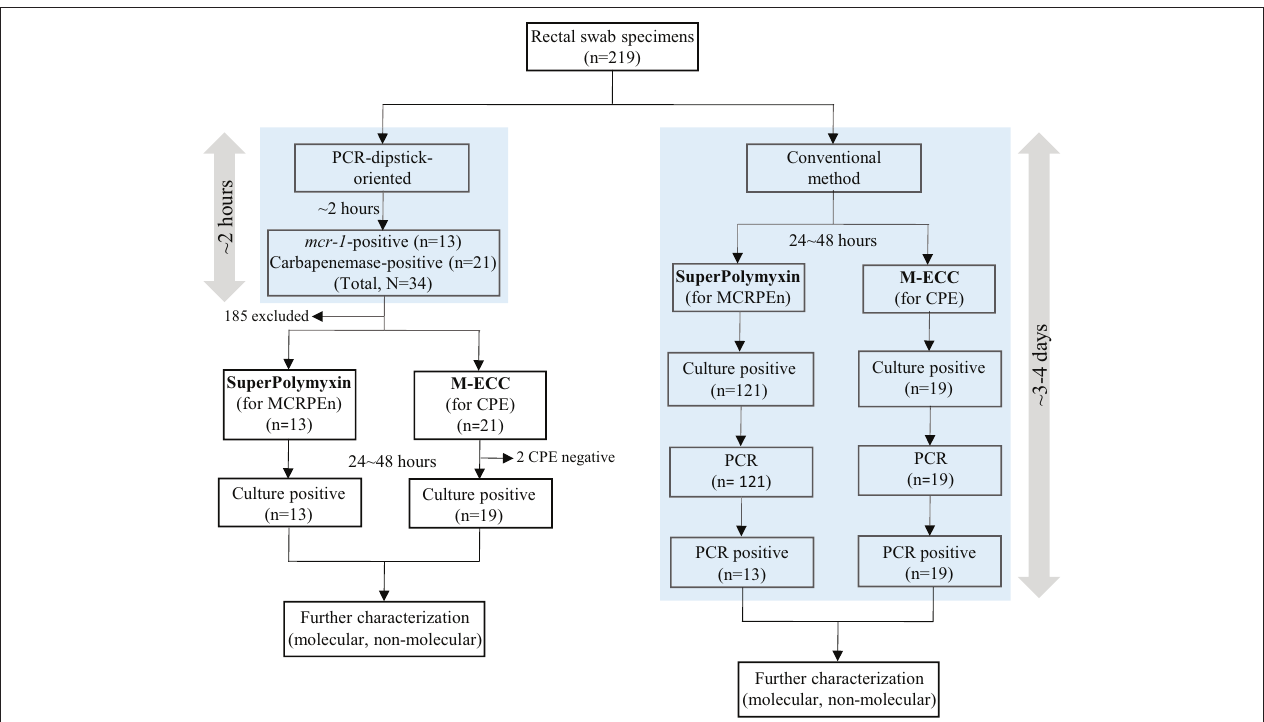
FIGURE 1 | Flow diagram of PCR-dipstick-oriented and conventional surveillance method. All the rectal swab specimens were subjected to PCR-dipstick-oriented and conventional surveillance method. PCR-dipstick detected the presence of resistance genes within 2h and thus, only the specimens detected with resistance genes were cultured on selective media for the isolation of MCRPEn and CPE. In the conventional method, all of the specimens were cultured on the selective media and all the isolates grown (24 ∼ 48h) on them were screened for the resistance genes using PCR.